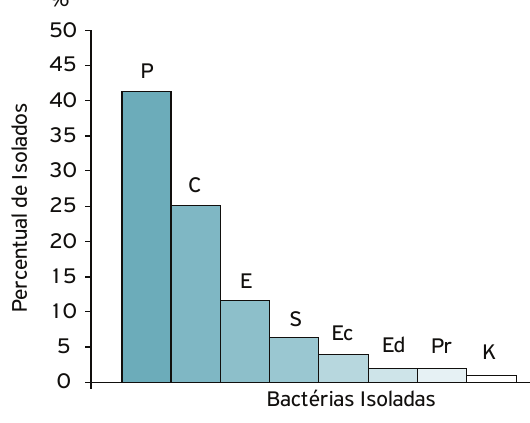
Figura 1. Enterobactérias isoladas de amostras de esfregaços cloacais de